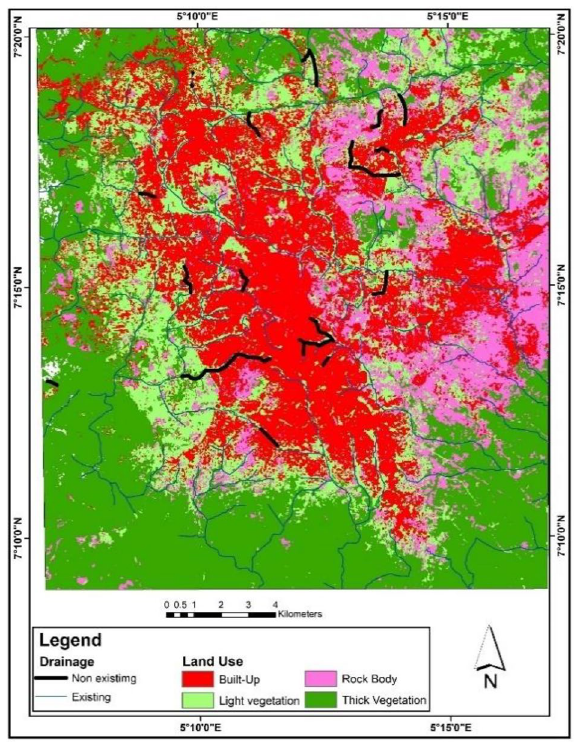
Fig. 4 symmetric difference of drainages in 2002 and